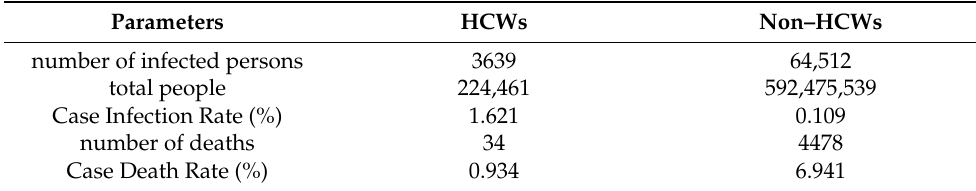
Table 4. Comparison of Case Infection Rate and Case Death Rate Between HCWs and Non–HCWs in Hubei.